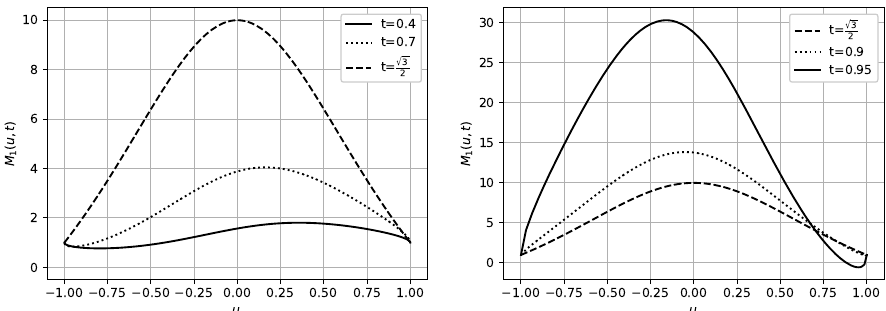
Figure 7. Plots of the functions M 1 ( · , t ) for some t